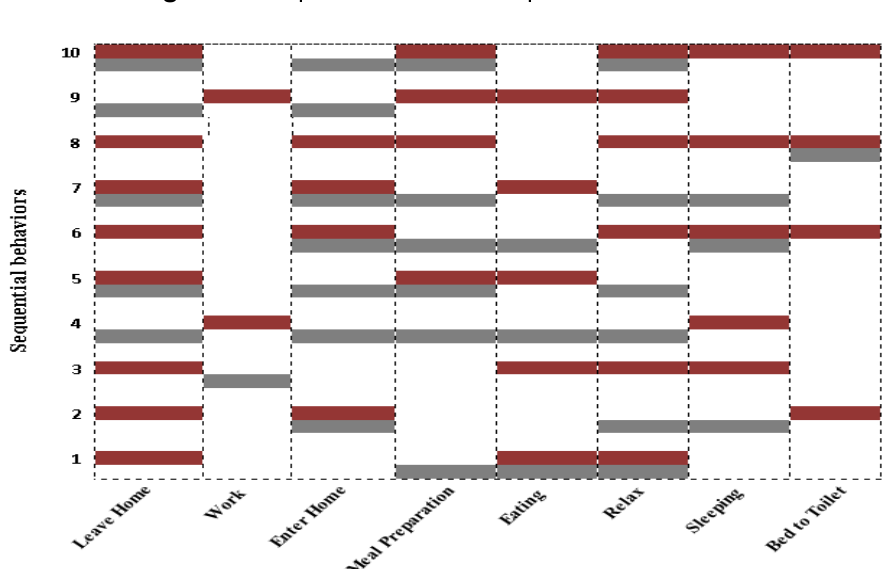
Figure 7. Sequential behavioral patterns for